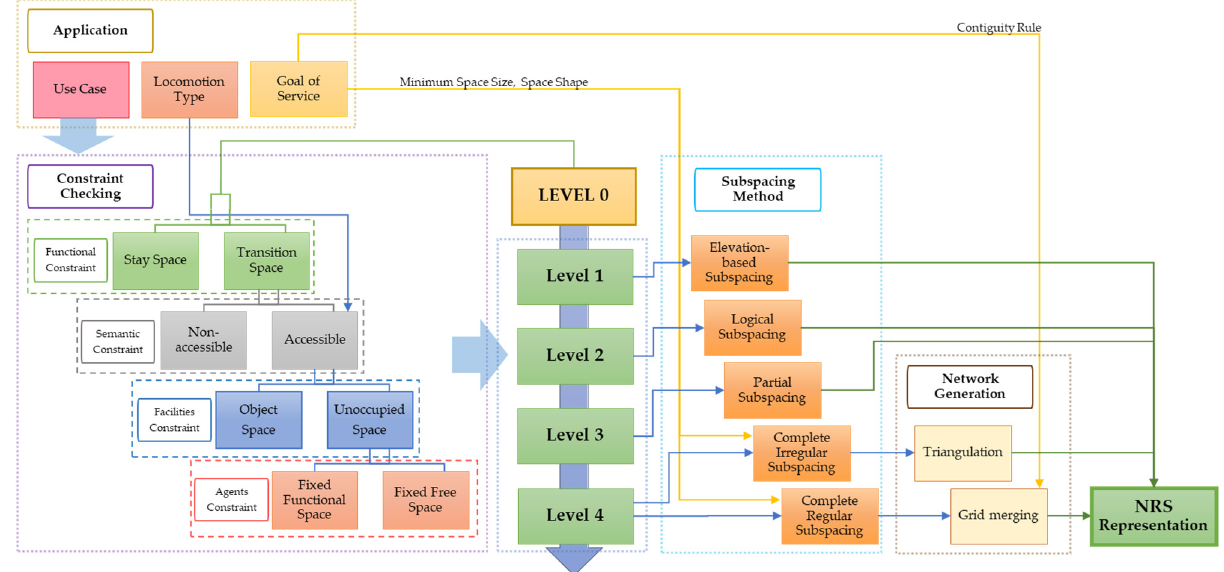
Figure 9. Framework for generating a multi-level hierarchical indoor navigation network.